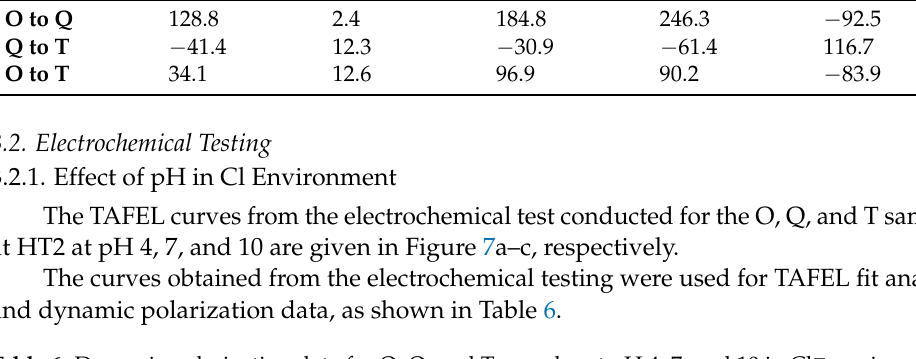
Table 6. Dynamic polarization data for O, Q, and T samples at pH 4, 7, and 10 in Cl −